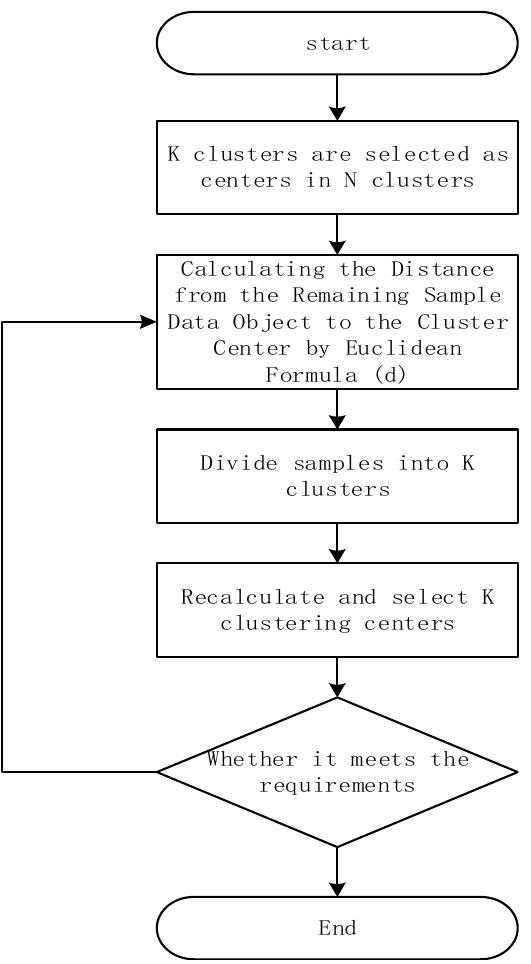
Figure 3. K-Means algorithm implementation